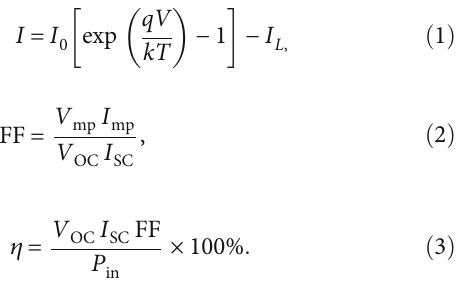
NH PbI Cl x and (b) CH 3 3 3- x